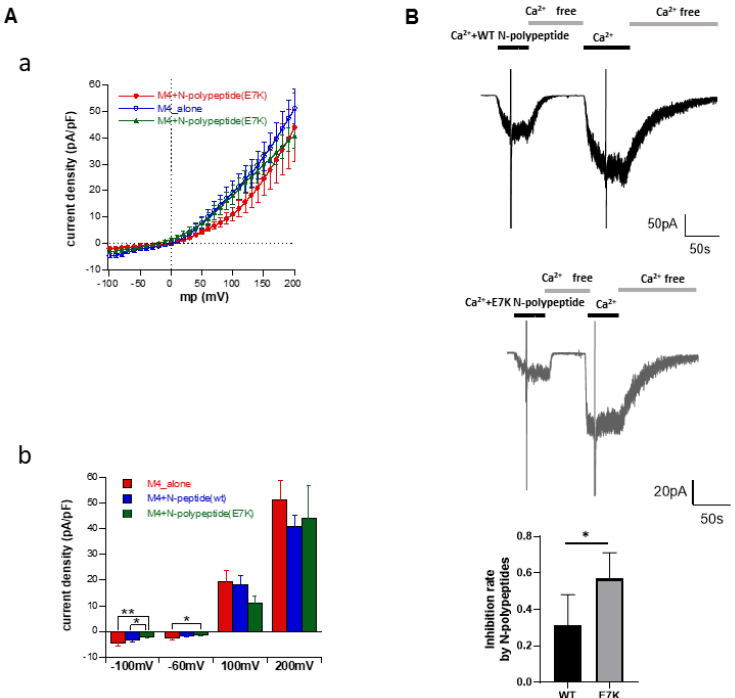
Figure 5. Different degrees of inhibition by WT- and E7K-N-terminal polypeptides of TRPM4 chan- nels. ( A ) Current-voltage (I-V) relationships of full-length WT-TRPM4 channel co-expressed in HEK293 cells with either WT- or E7K-N-terminal polypeptides (the first 100 amino acid residues), or an empty vector alone (a). TRPM4 current was induced by 1 μM Ca 2+ under the whole-cell con- ditions. The densities of inward and outward TRPM4 currents were compared at membrane poten- tials of −120, −60, 100, and 200 mV (b). The E7K polypeptide was more effective than WT polypeptide at inhibiting whole-cell TRPM4 currents. *: p < 0.05 with ANOVA followed by Tukey’s post hoc tests ( n = 7). Only the pairs of columns that show statistically significant differences are shown. ( B ) Direct application of short synthetic N-terminal polypeptides containing the ‘WT’ and ‘E7K’ sequences suppressed single-TRPM4 channel activities induced by 100 μM Ca 2+ at −60 mV. Representative data from two inside-out patches showing greater inhibition by E7K- than WT polypeptides. *: p < 0.05 with unpaired t-test, respectively ( n = 5).